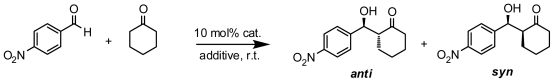
Asymmetric aldol reaction of 4-nitrobenzaldehyde and cyclohexanone.